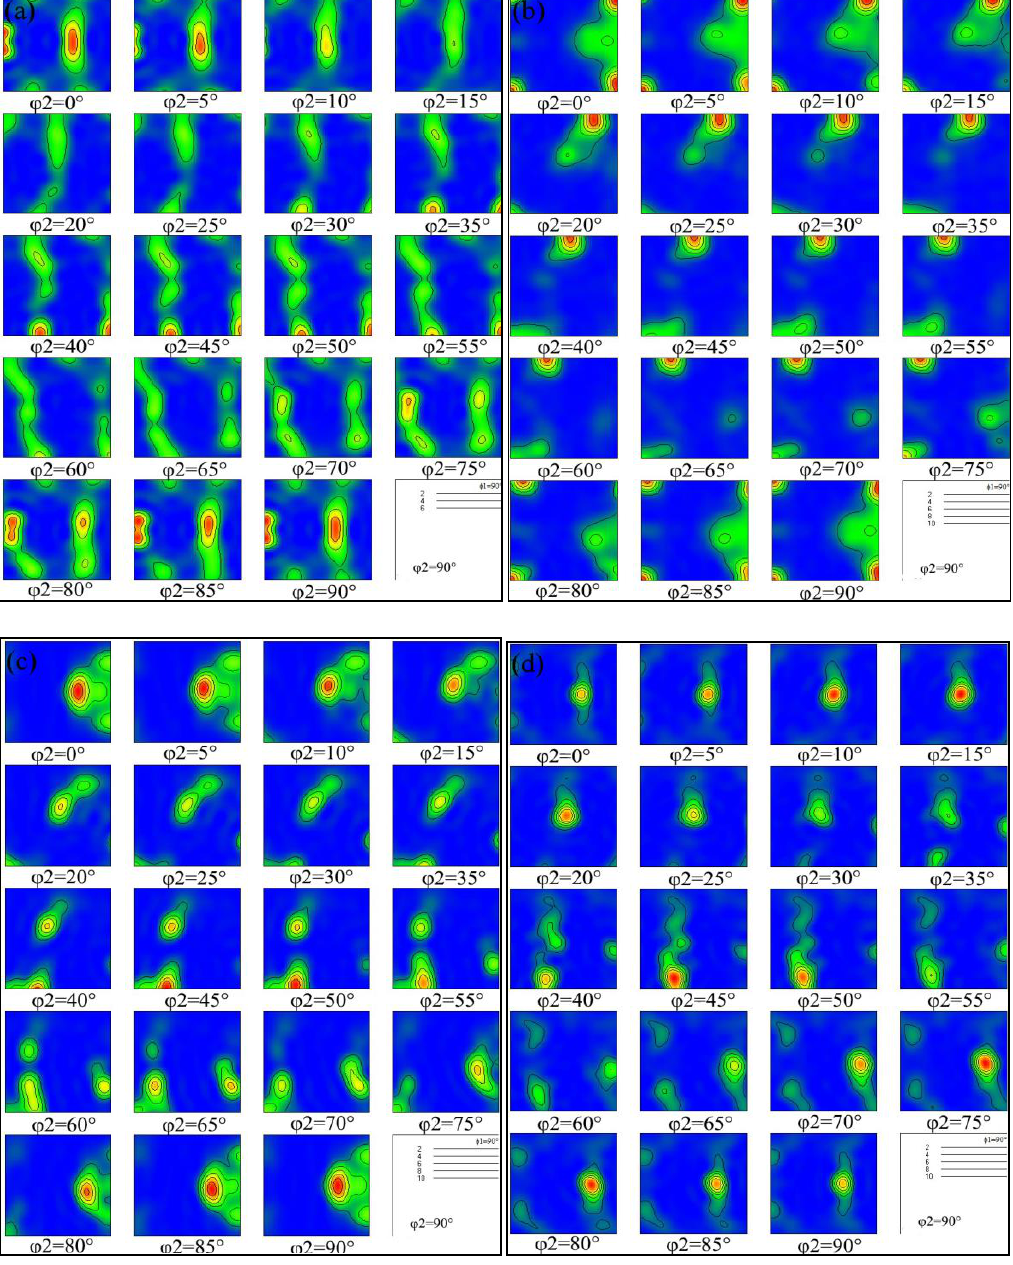
Figure 3. Orientation distribution function (ODF) of the Cu1.5Cr0.1Si alloy after C-path ECAP deformation and aging at 350 °C for 4 h. ( a ) one pass ( b ) two passes ( c ) four passes ( d ) eight passes.